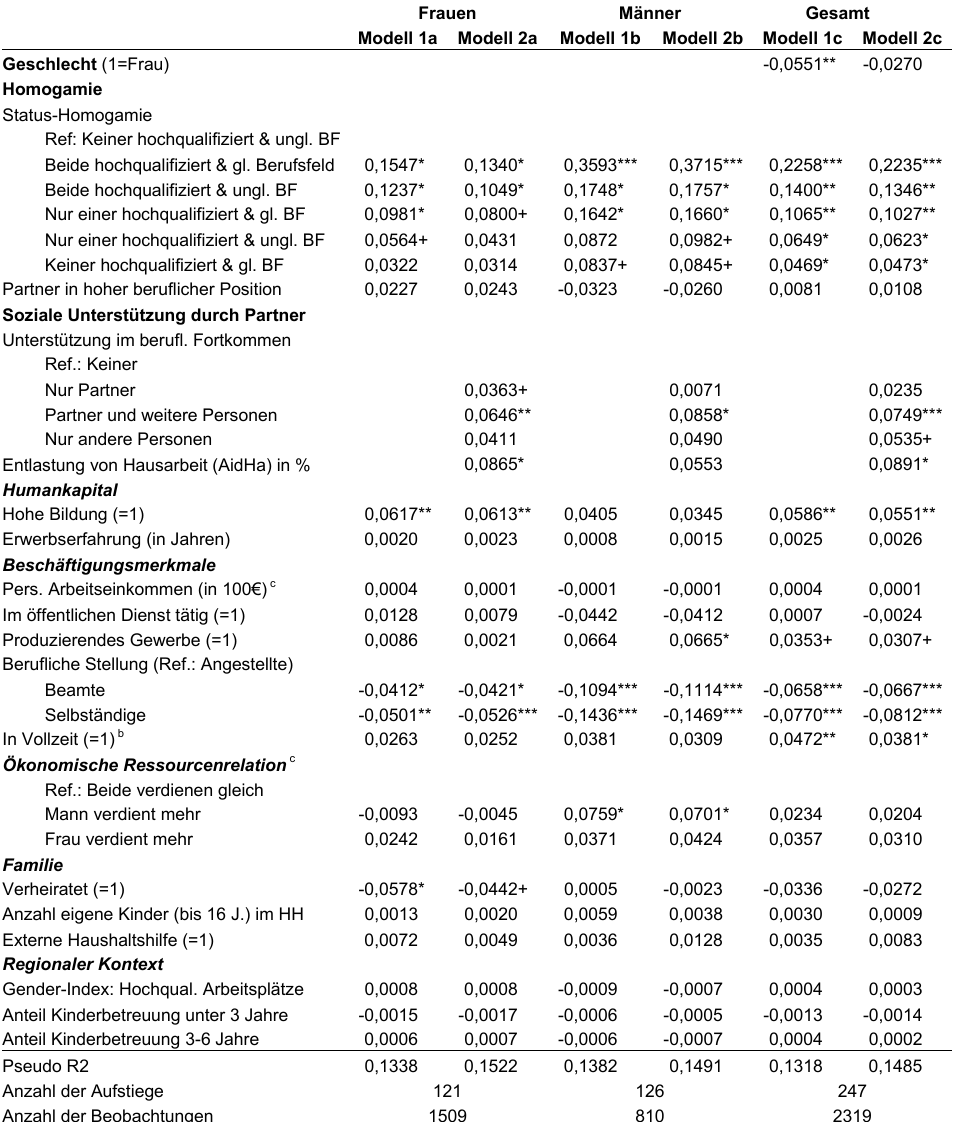
Tabelle 3 : Determinanten der Aufstiege in hohe berufliche Positionen